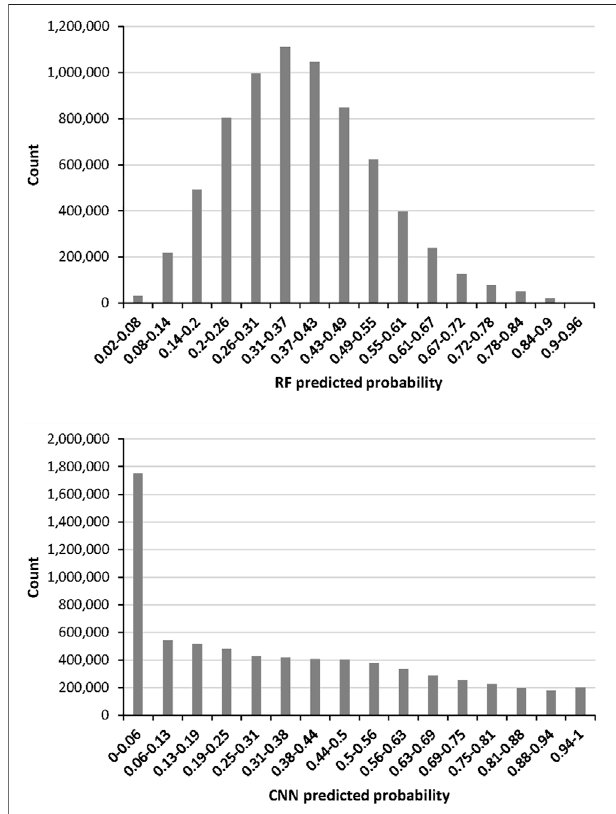
FIGURE 4 | Distribution of the predicted probability for potential acid sulfate soil occurrence generated using Random Forest (RF) with scaled covariates (top) and Convolutional Neural Networks (CNN;